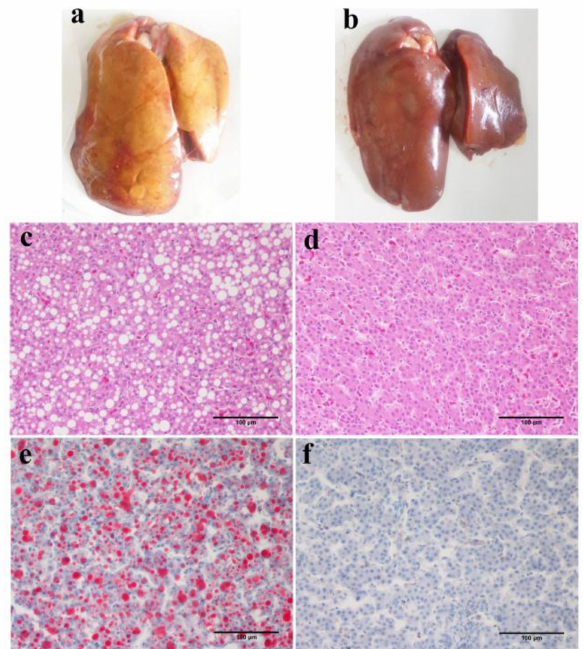
Figure 3. Typical features of fatty liver in terms of gross appearance and sections stained with hematoxylin-eosin(H&E) or oil red O (20 × ). The fatty liver appears yellow or light yellow and the edge of the liver is blunt and friable ( a ). Enlarged liver cells with abundant fat droplets of different sizes are present in the cytoplasm and liver leaflets lost the normal reticular formation ( c , e ). In comparison, the non-fatty liver was dark red with sharp edges, the texture was flexible and there were less fat droplets and clear reticular formations in liver leaflets ( b , d , f ). ( a , c , e ) were from one JXH chicken with HF diet; ( b , d , f ) from one JXH chicken with basal diet. Scale bar: 100 µ m.